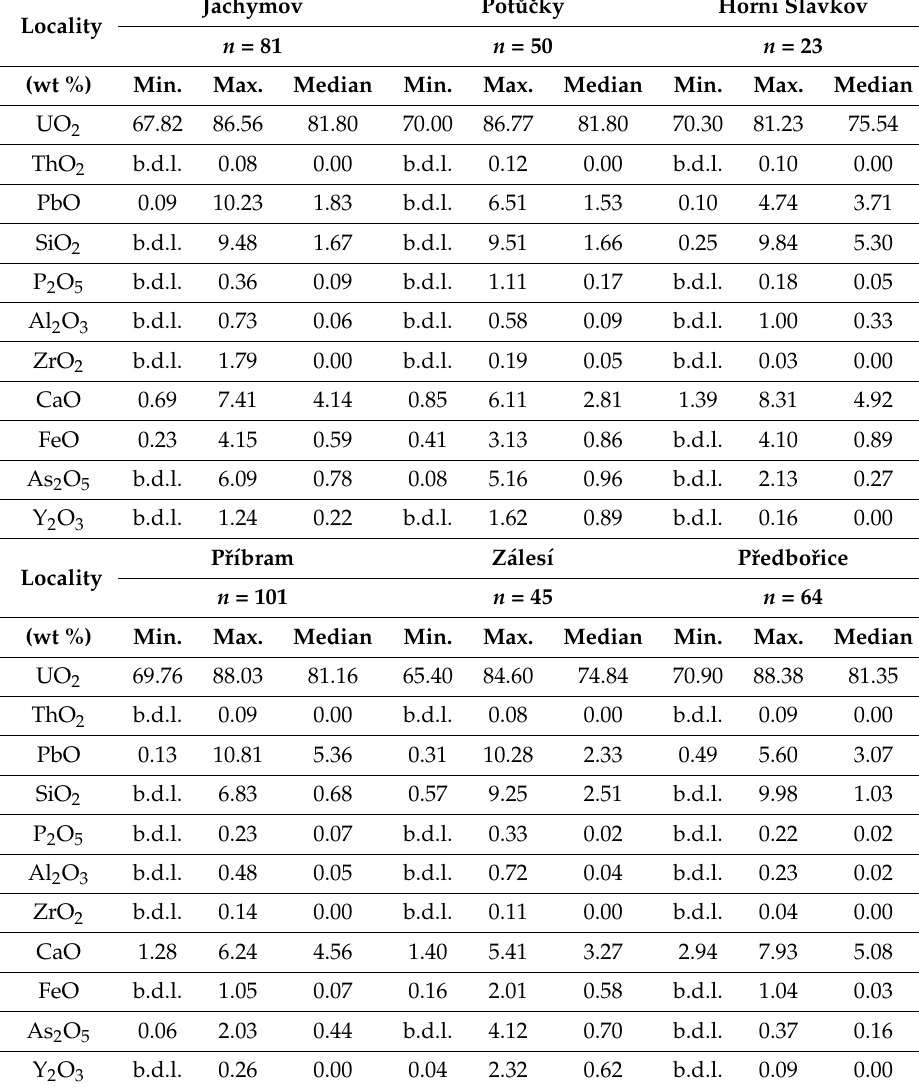
Table 1. Ranges of selected components in the uraninites studied. J á chymov Locality